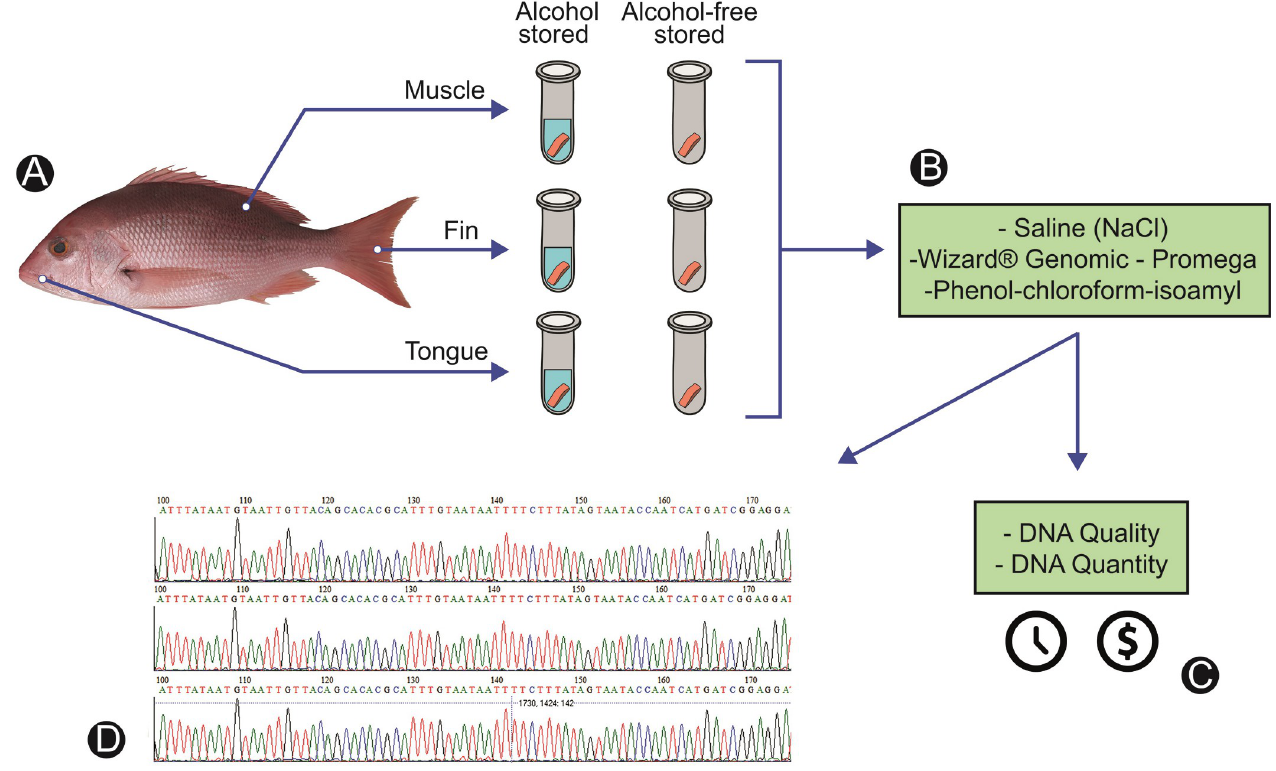
Fig 1. Flow diagram summarizing the experimental design. A: Species selection and tissue removal and storage conditions. B: DNA extraction with the three compared protocols. C: Analyzed variables, quality, and quantity of extracted DNA, costs, and time for sample processing according to the three extraction protocols. D: Verification of functional sequences from DNA